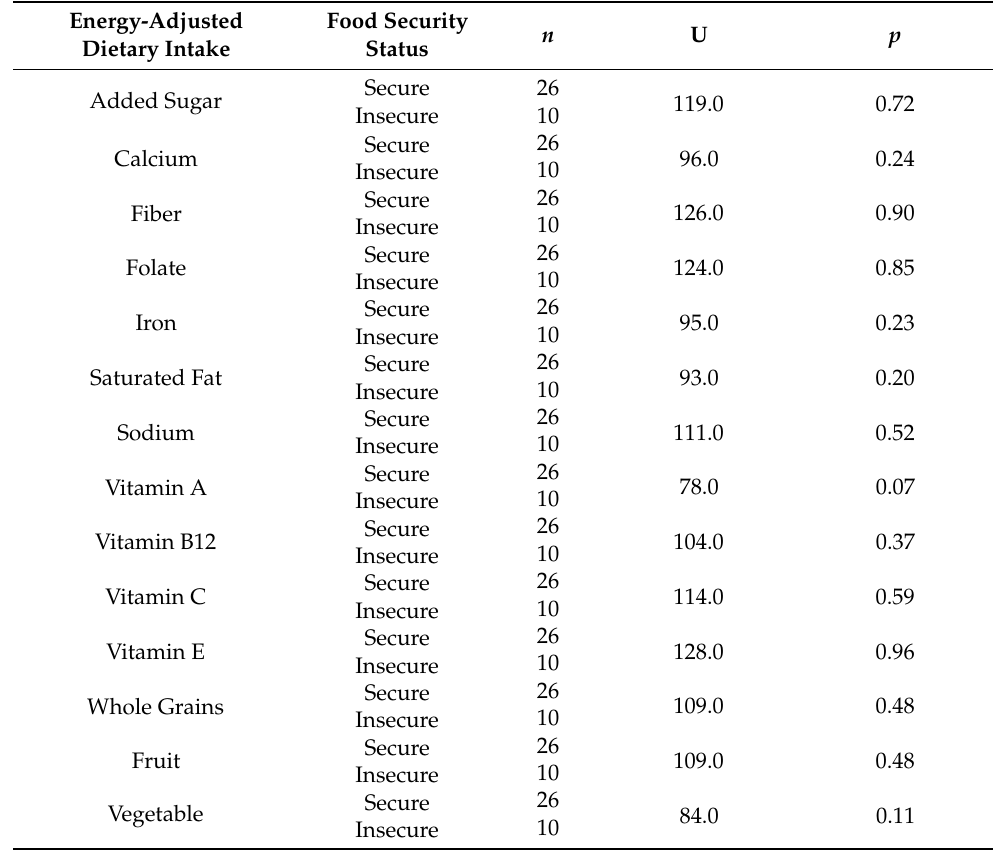
Table 6 contains the results of the comparisons of the dietary intake variables by partic- ipant food security status. The energy-adjusted dietary intakes did not differ significantly based on food security status. Table 6. Comparisons of dietary intake variables by food security